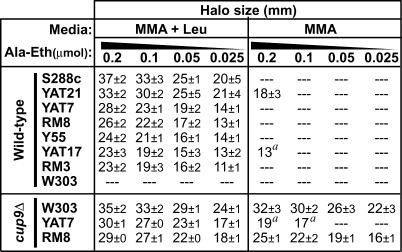
Halo Assay for Uptake of the Toxic Ala-Eth DipeptideCells were plated onto MMA with or without 30 μg/ml leucine, an inducer of PTR2 expression. Halo diameters in the presence of discs containing the indicated Ala-Eth concentrations are presented as the mean ± standard deviation. (ptr2Δ strains were also tested, and exhibited no halos.)
aHalo boundary was indistinct, often slowly receding as cells closer to the disc began to grow.